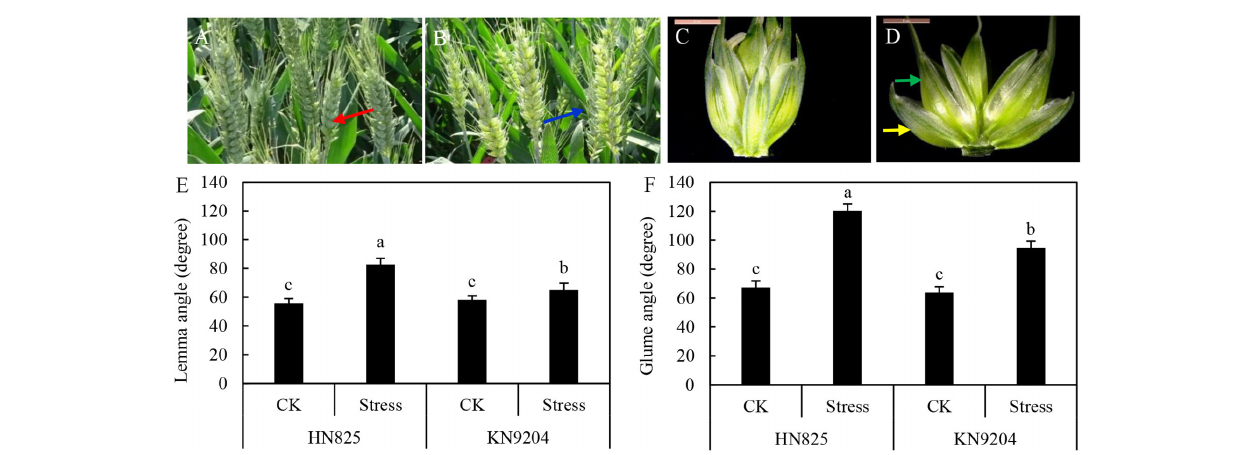
FIGURE 4 | Measurement of glume and lemma angle in ‘HN825’ and ‘KN9204’. Spike (A,B) and spikelet (C,D) images of control (A,C) and low light stress (B,D) at early grain filling stage (20 days after low light treatment). (E) The lemma angle. (F) The glume angle. The red arrows indicate the spike in control (A) , the blue arrows indicate the spike in stressed spike (B) , the yellow arrows indicate the glume, and the green arrows indicate the lemma (D) . Different letters indicate the statistically significant differences between treatments ( P < 0.05). Scale bars are 5 mm.